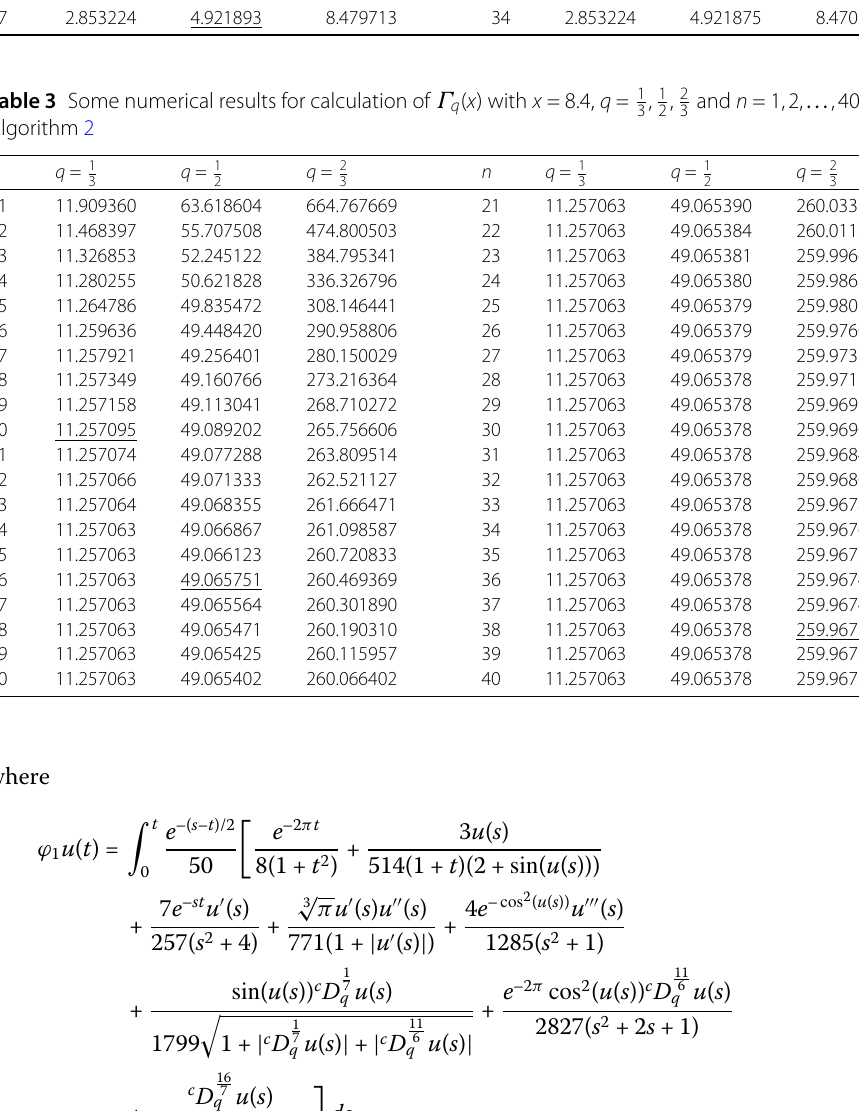
Table 2 Some numerical results for calculation of Γ q ( x ) with q = 1